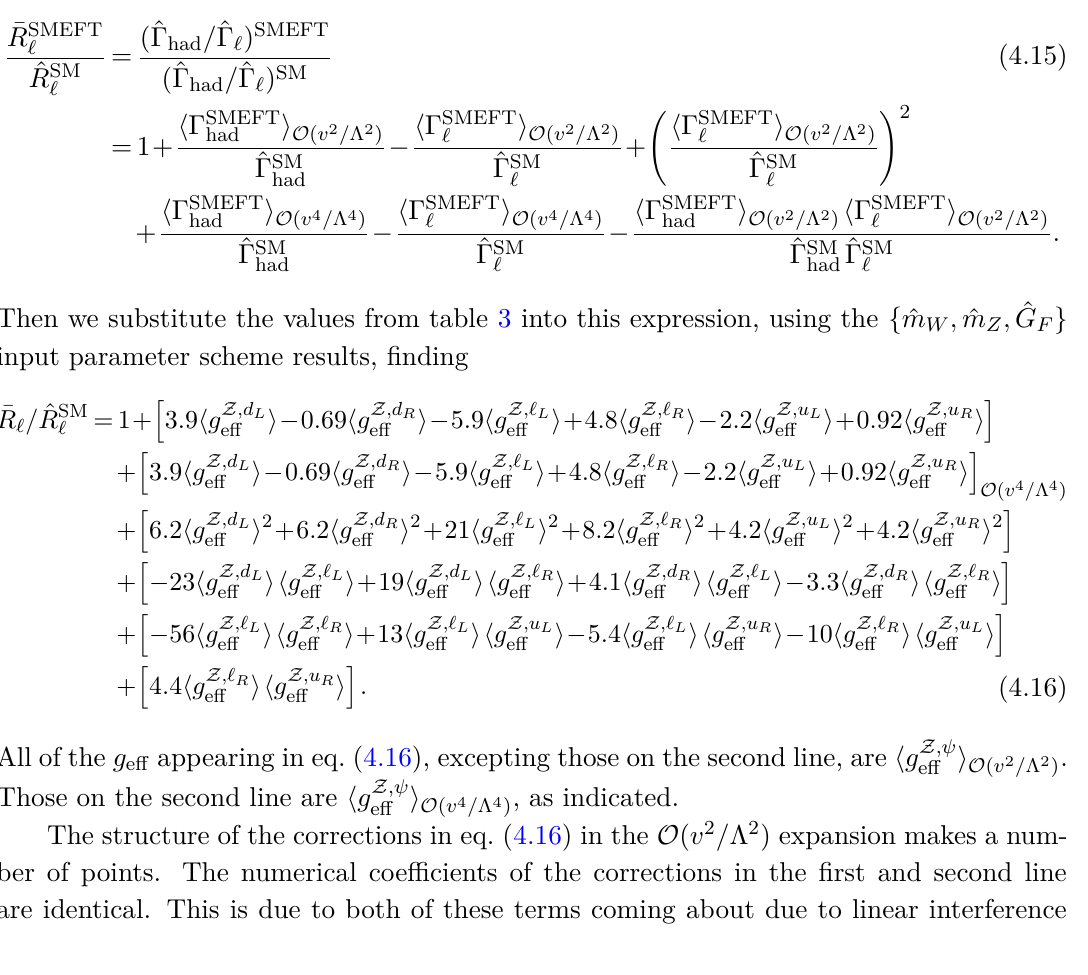
Table 5 . The effective couplings expanded to O ( v 2 / Λ 2 ) in each input parameter scheme. δG (6) is defined in ref. [16]. Reported is the numerical coefficient multiplying each SMEFT correction. p = { 1 , 2 , 3 } is a flavor index. The operator subscript labels ψ take on the values { u R , d R , ‘ R , q L , ‘ L } , with the effective coupling ψ label dictating the value of ψ